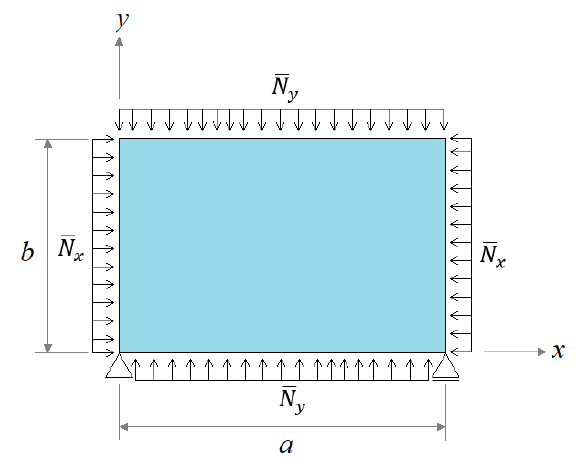
Figure 2. Simply supported square plate without holes.